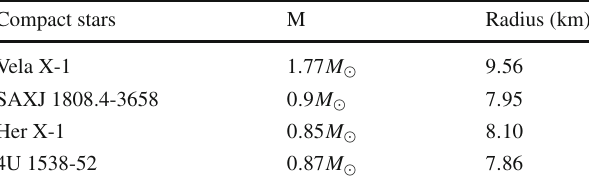
Table 1 The numerical values of the masses and radii of the compact stars [24]. In the table below M (cid:10) represents the mass of the sun Compact stars